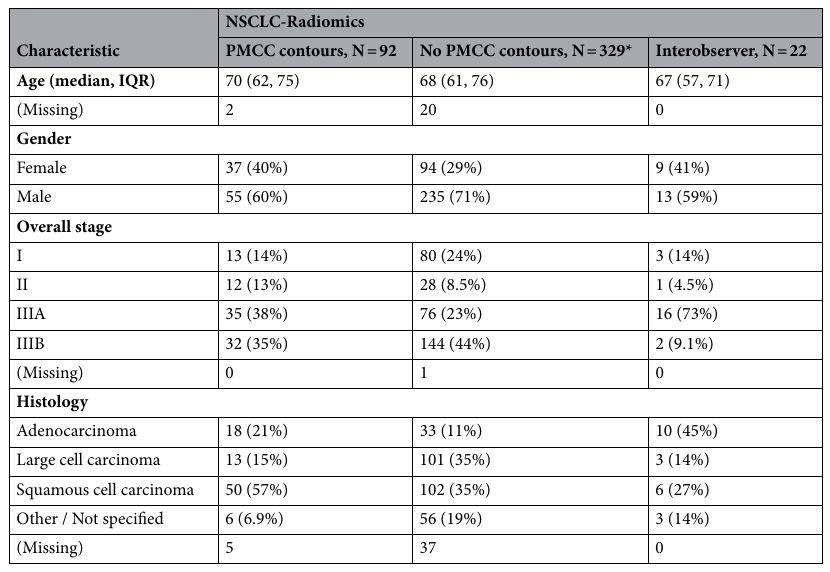
Table 1. Clinical characteristics. N = number; PMCC = Peter MacCallum Cancer Centre; IQR = interquartile range; *excludes 1 patient who underwent surgery prior to